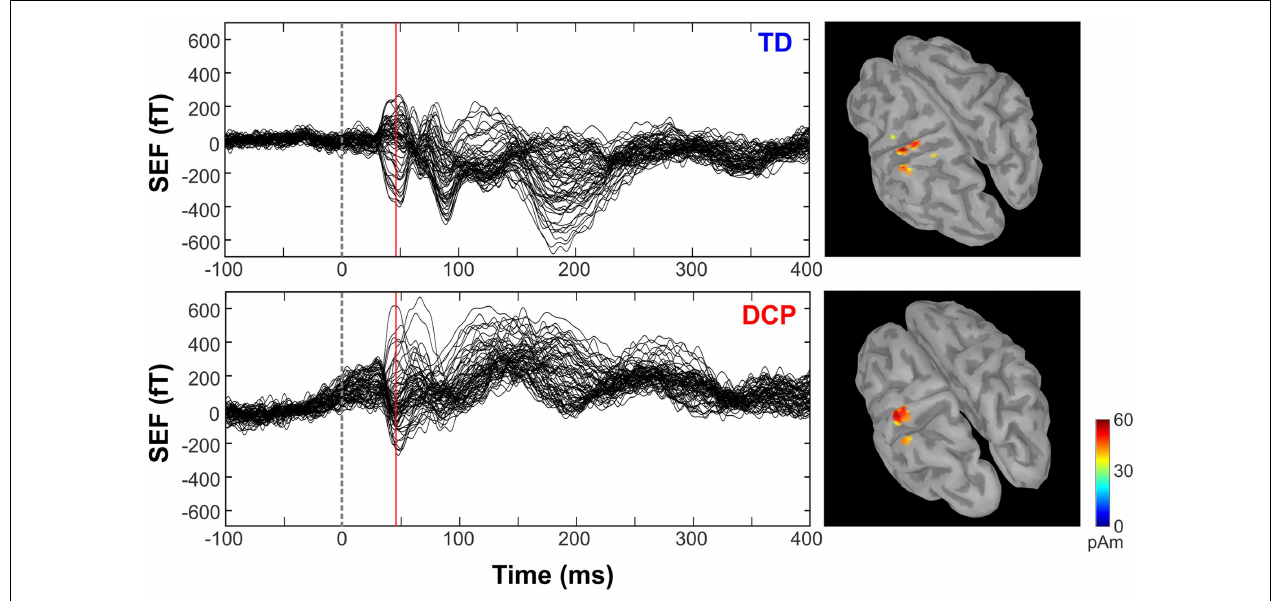
FIGURE 2 | Somatosensory-evoked fields evoked by the tactile stimulation of the right D1 (left panels) forTD1 and DCP2 (left hemisphere more affected) children respectively from − 100 to 400ms . MNEs (in pico ampere meter) overlaid on participant cortical surfaces at the peak of